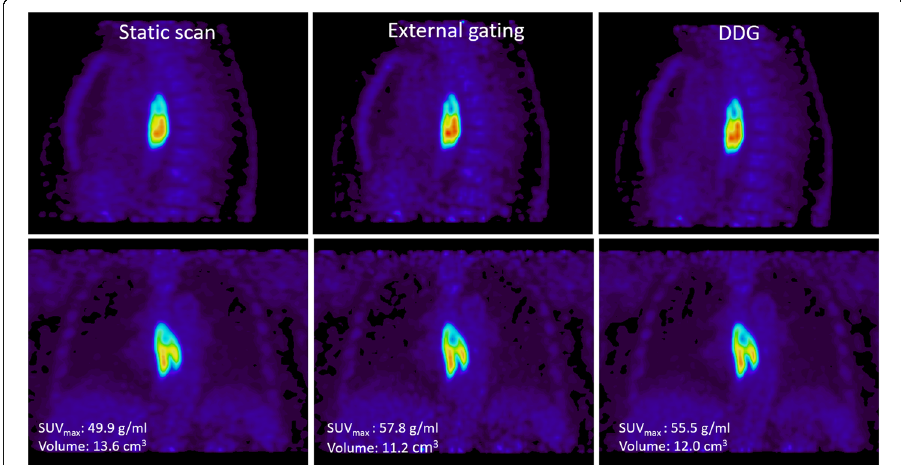
Fig. 4 Example of a patient with an esophageal tumor. Images reconstructed from static raw data (left) and from raw data based on external hardware gating (middle) and DDG